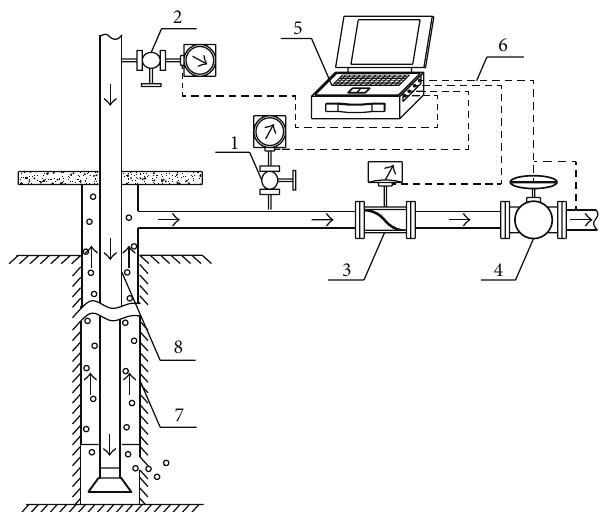
Figure 1: Schematic diagram of pressure response testing ( (1) back pressure sensor, (2) stand pipe pressure sensors, (3) gas-liquid flow meter, (4) electronic valve, (5) IPC (industrial personal computer), (6) command lines, (7) casing pipe, and (8) drill